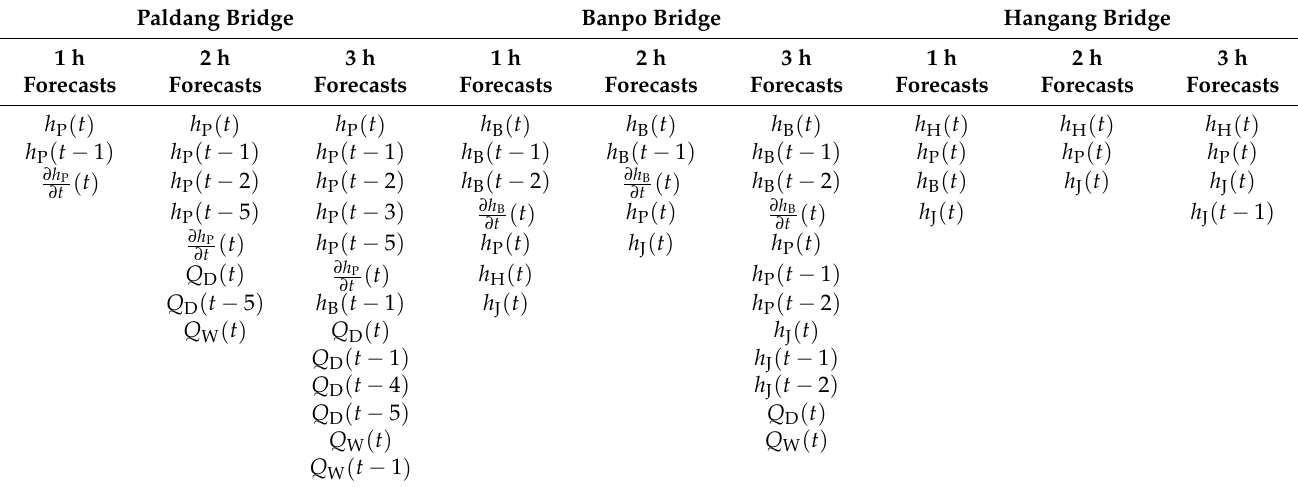
Table 2. Selected input variables for